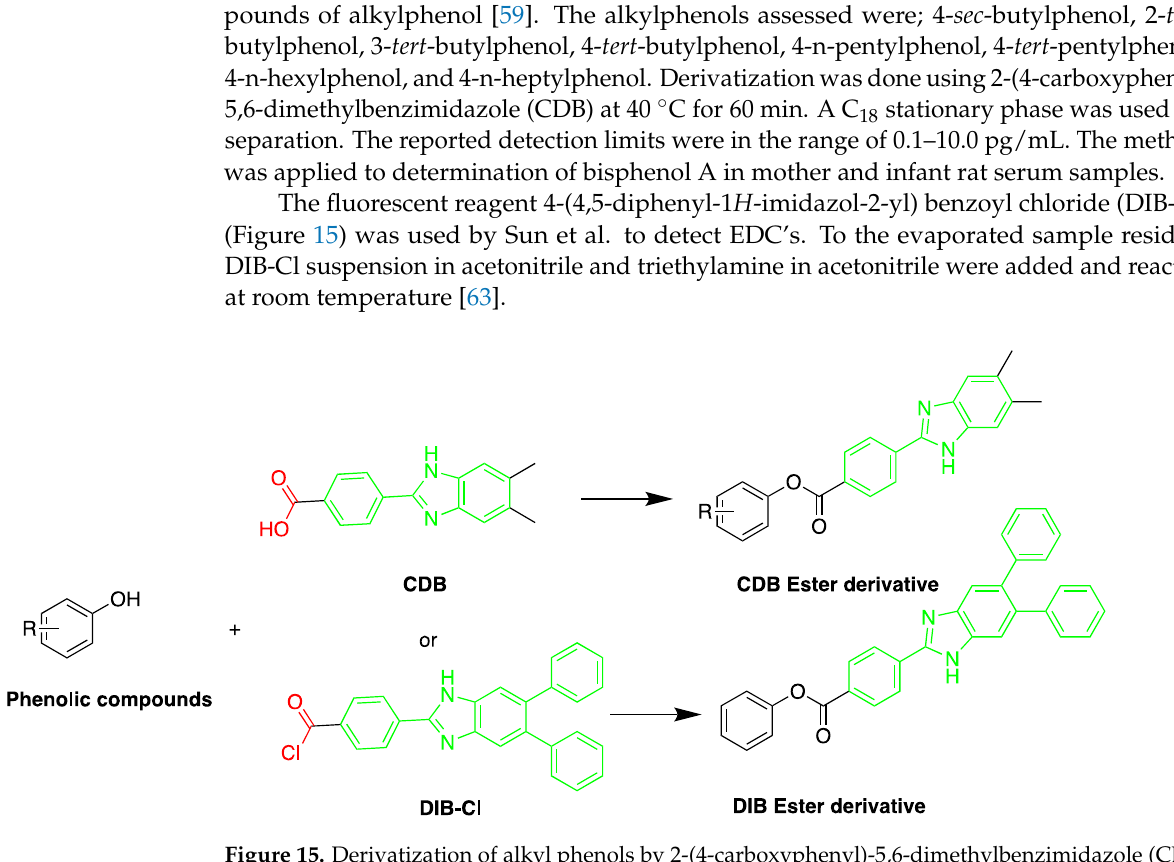
Table 2. HPLC-FLD method conditions used for steroid detection.